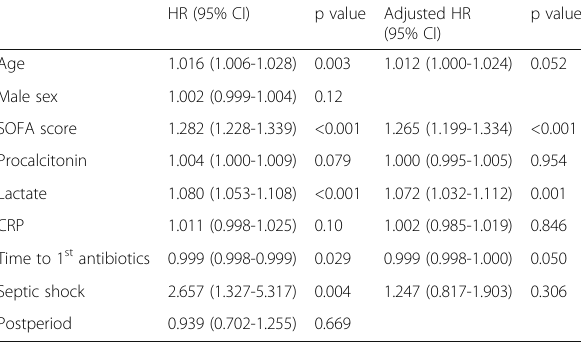
Table 2 (abstract P13). Univariate and Multivariate Cox Regression Analysis of Risk factors for 28-Day Mortality in patients with sepsis and